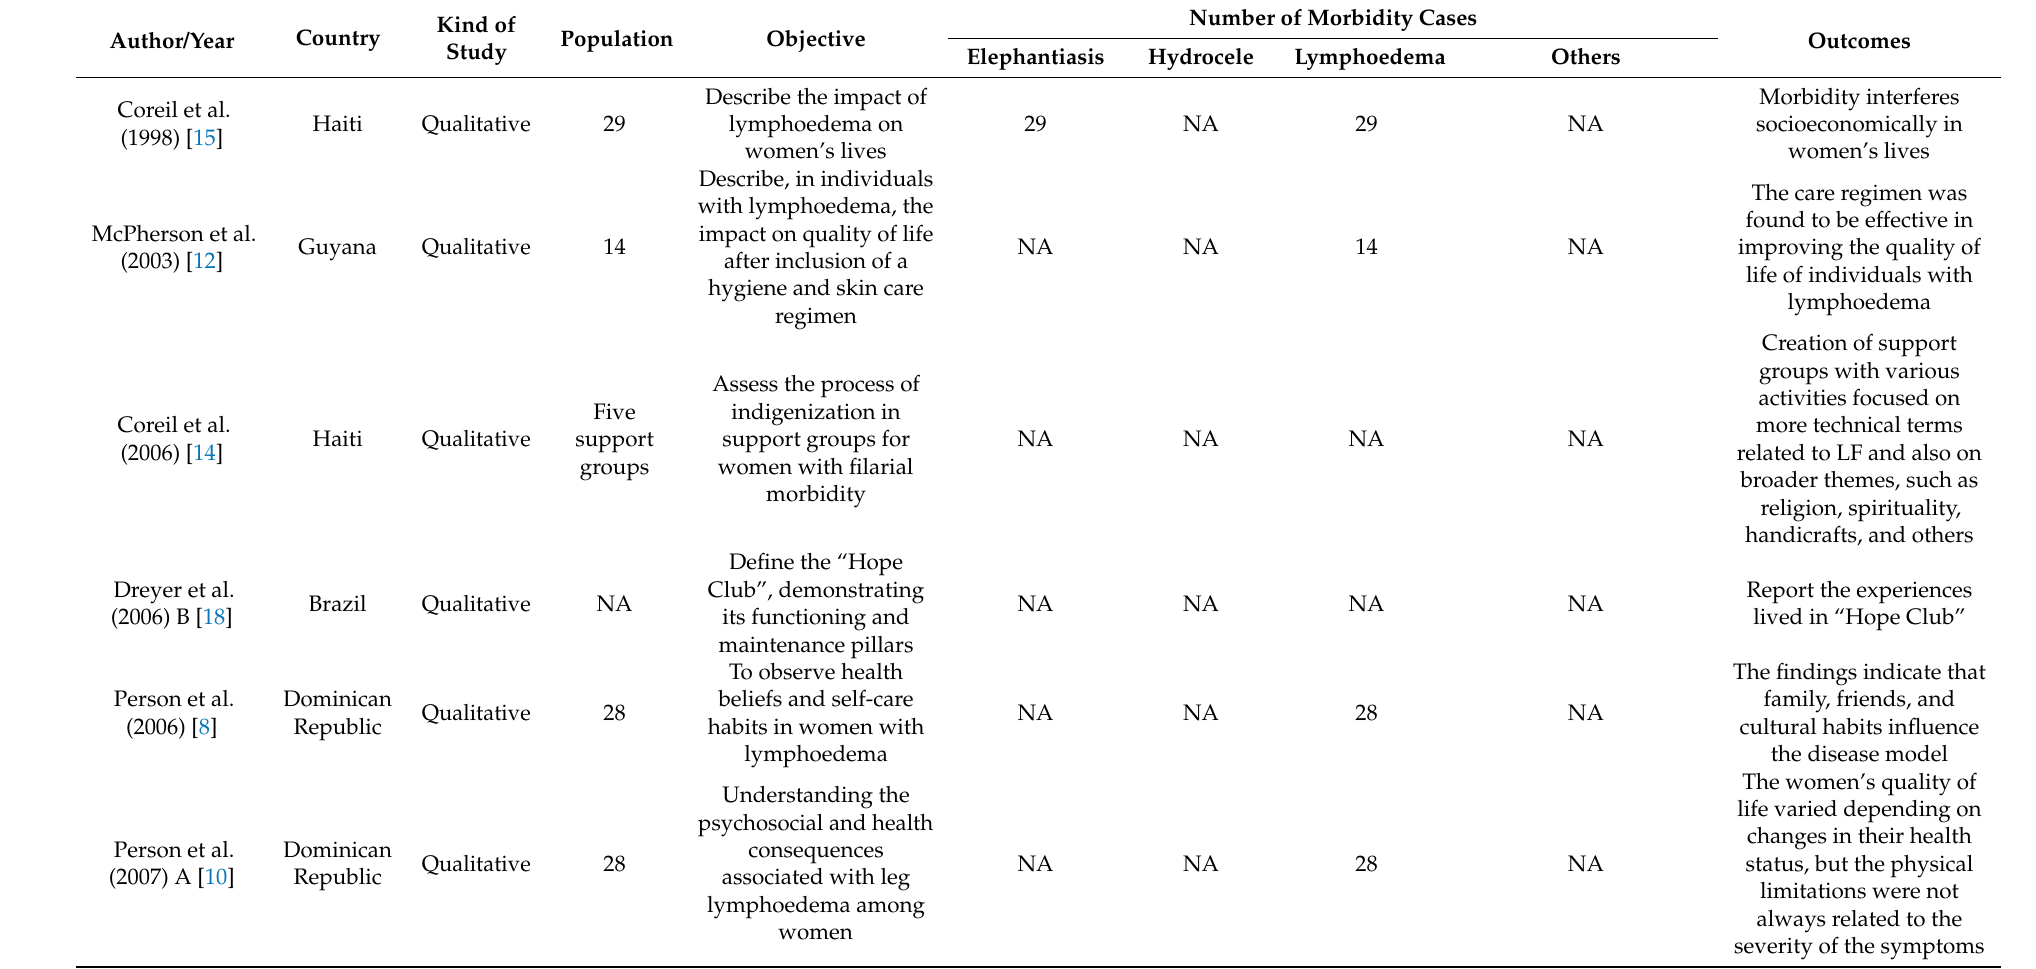
Table 2. Details of data extracted from qualitative